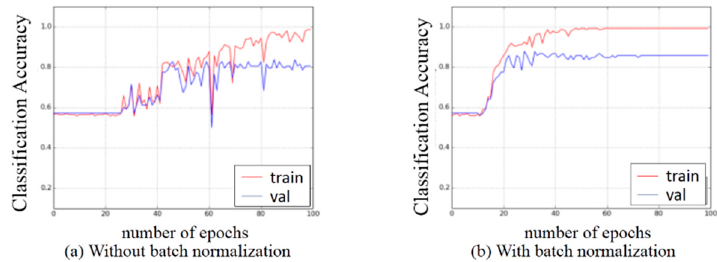
Figure 7. Comparison of performance with and without batch normalization. ( a ) Without batch normalization; ( b ) With batch normalization.